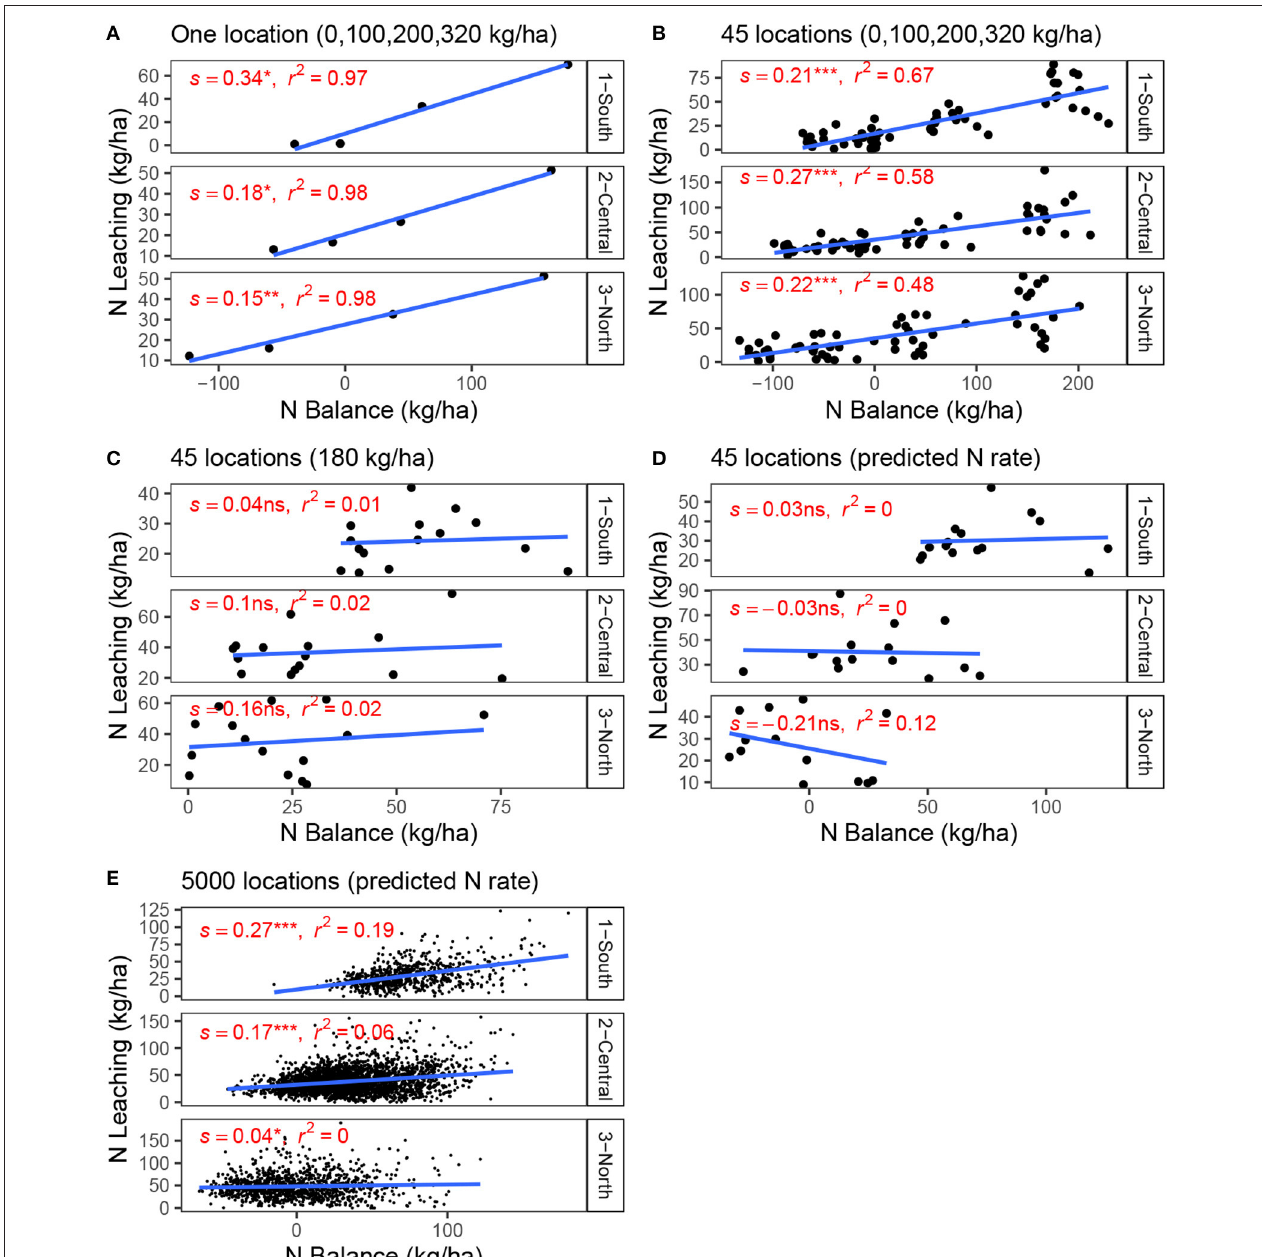
FIGURE 5 | N balance vs. N leaching relationship with the increasing complexity of the dataset. Locations are a field x year combination randomly selected from the 128,100 available locations (4270 fields x 30 years). (A) One location with four fixed N rates (trial). (B) A total of 45 locations with four fixed N rates (trials). (C) Several locations using the same fixed N rate. (D) A total of 45 locations using the N rate predicted by the random forest tool at base-level situation. (E) A total of 5,000 locations using the N rate predicted by the random forest tool at base-level situation. Linear regressions were fitted independently to each set of data, and report the estimate of the slope (s), test of significance (ns = non-significant; *= p < 0.1, **= p < 0.05; ***= p < 0.01), and coefficient of determination ( r 2